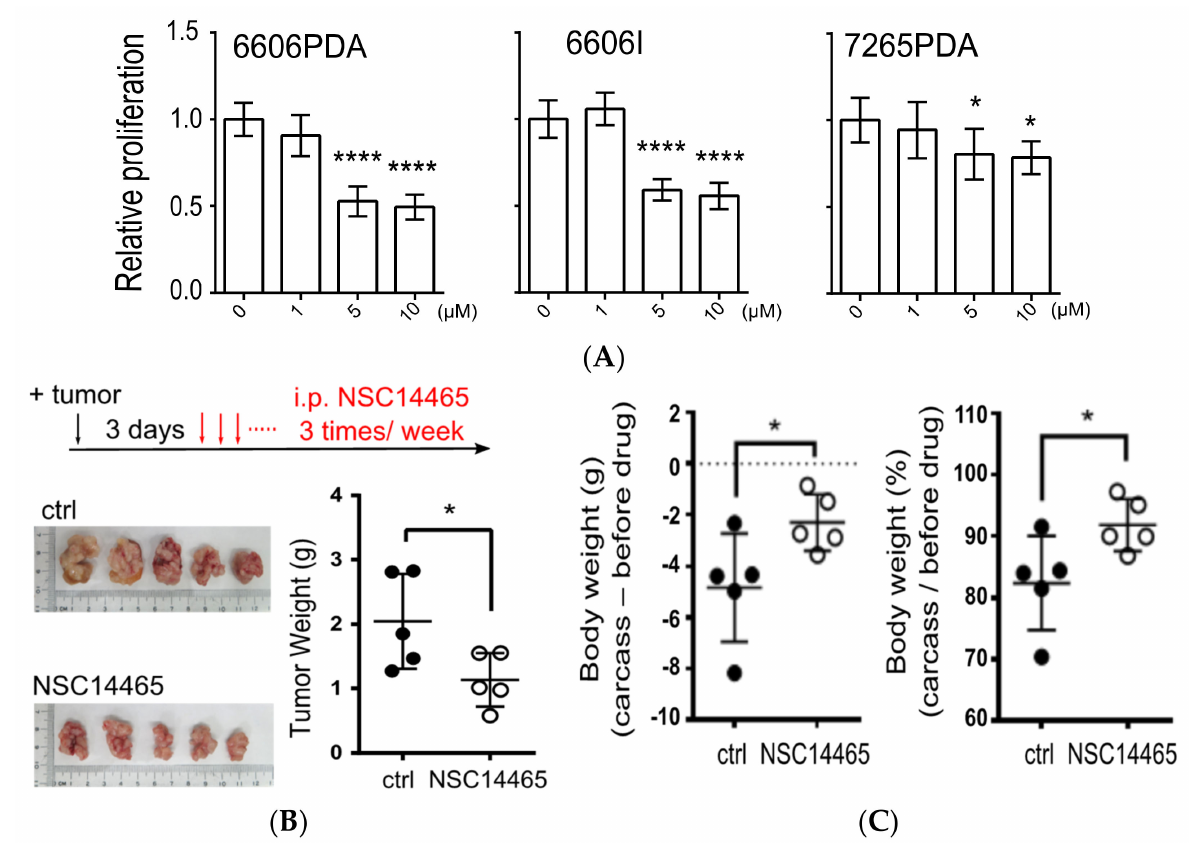
Figure 5. Anti-tumor effects of NSC14465. ( A ) Proliferation assays using mouse pancreatic cancer cell lines following treatment with NSC14465 for 3 days. ( B ) Comparison of tumor weights from mice orthotopically injected with 6606PDA followed by vehicle control or NSC14465 treatment. i.p. intraperitoneal injection. 1% DMSO/PBS (phosphate buffered saline) served as vehicle control. ( C ) Comparison of body weight changes in mice following NSC14465 treatment. Before drug: mice right before vehicle or NSC14465 treatments. Student’s t -test: * p < 0.05, **** p <